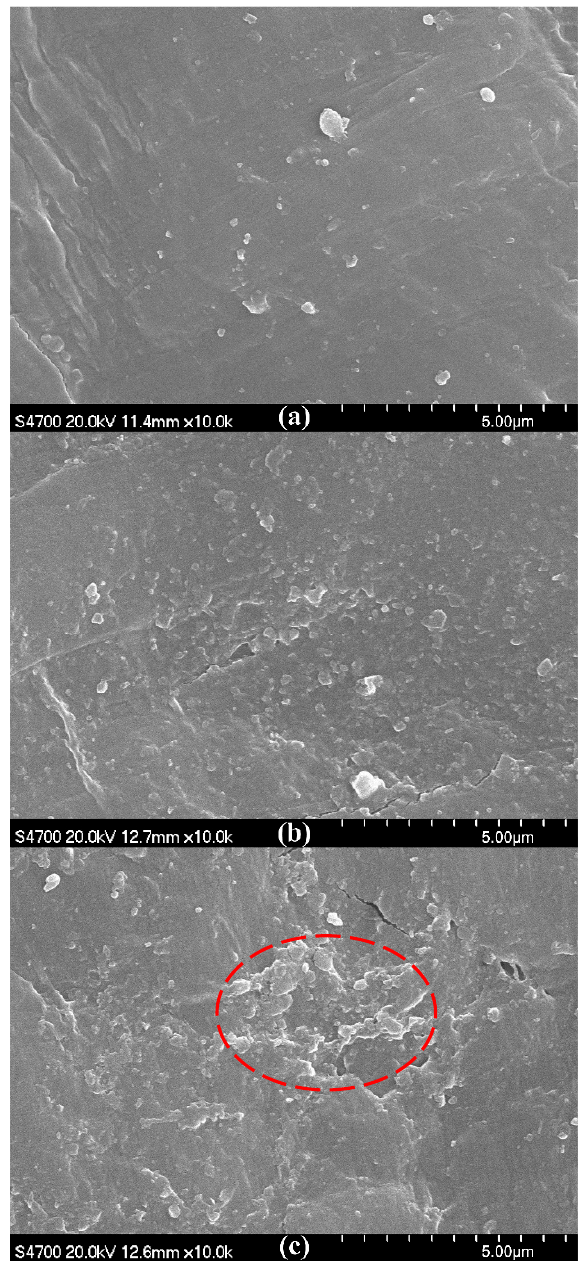
Figure 3. SEM micrographs of fracture surfaces of OMMT-modified UHMWPE pipes. ( a ) w OMMT = 5%, ( b ) w OMMT = 8%, ( c ) w OMMT = 10%.